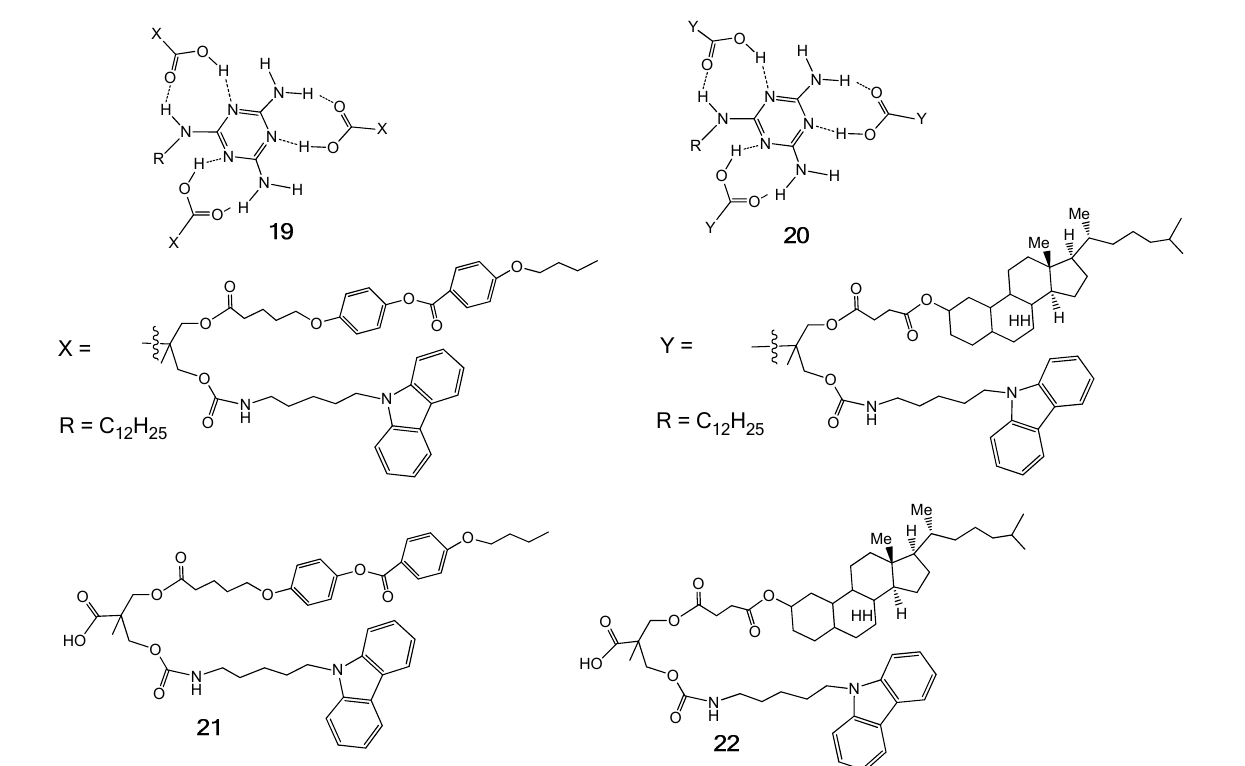
Figure 12. Structures of dendrimers ( 19 ) and ( 20 ) and and dendrons ( 21 ) and ( 22 ).